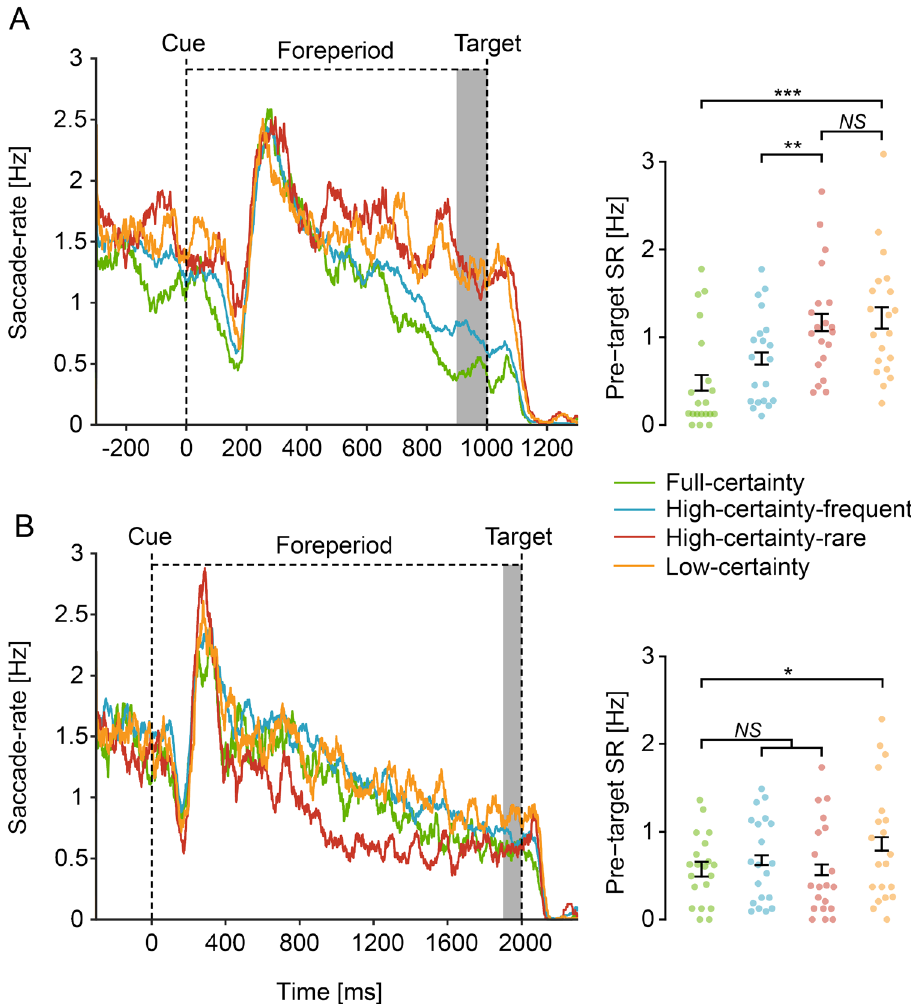
Figure 3. Saccade-rate results. Saccade-rate (SR) traces (left) relative to cue onset in 1 s ( A ) and 2 s ( B ) foreperiod trials, averaged across participants (N = 20). SR traces were smoothed using 50 ms running window for display purposes. Mean pre-target SR was averaged across − 100 to 0 ms relative to target onset (shaded region) and analyzed (right). Individual mean pre-target SR represented as dots for each condition. Error bars designate ± 1 within-subject standard error from the mean 33 . FDR-corrected p -values are reported for the planned contrasts conducted. SR traces were calculated and produced in Matlab 2018b 10 . Statistics were calculated and mean-pre target SR graph produced in R 18 using the afex package 19 . * p < .05; ** p < .01; *** p < .001; NS not